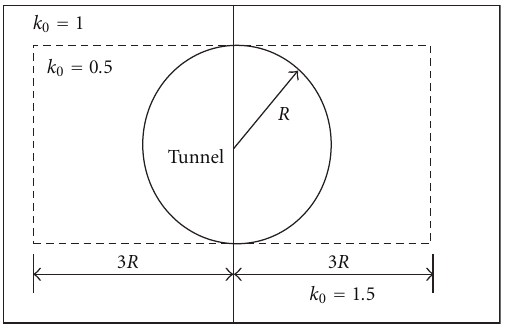
Figure 20: Layout of the zone of reduced k 0 (after